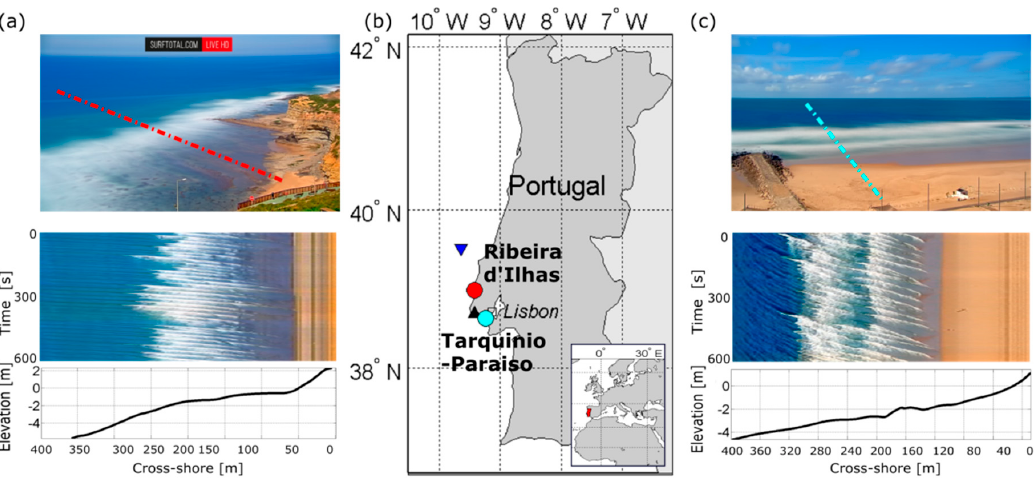
Figure 3. Study sites locations. (a) Timex image (upper), Timestack image (middle), and related beach profile (lower) at Ribeira d’Ilhas; (b) locations of the study sites. Blue and black triangles show offshore buoy and tide gauge positions, respectively; (c) Timex image (upper), Timestack image (middle), and related beach profile (lower) at Tarquinio-Paraiso beach. Note that the beach profile was not surveyed during video data acquisition and it is shown for a rough reference of bottom